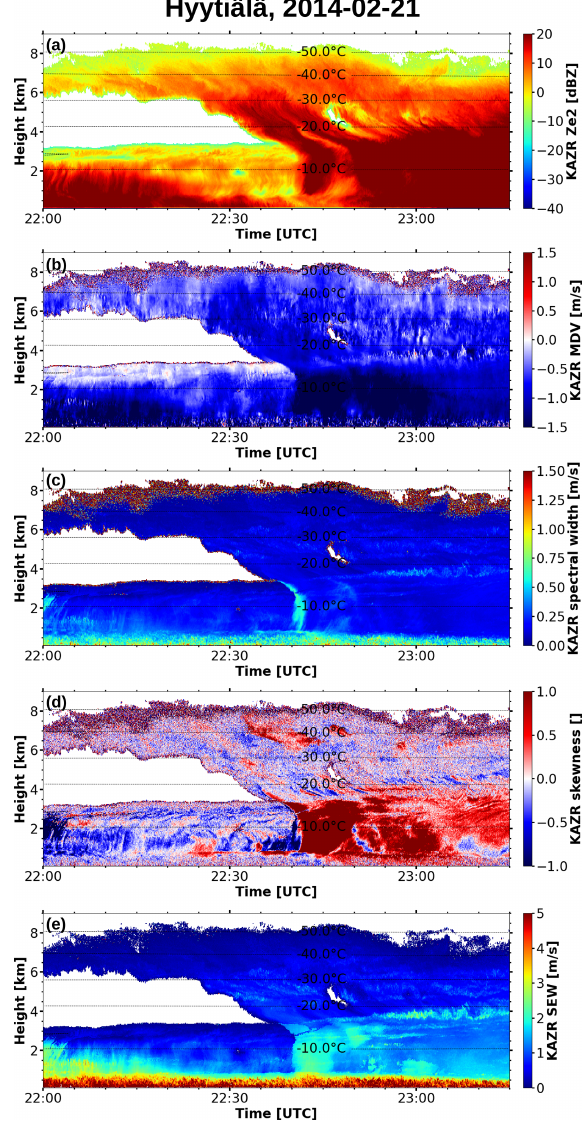
Figure 3. Radar moments measured by the KAZR in the focus pe- riod between 22:00 and 23:15UTC on 21 February 2014. (a) Equiv- alent radar reflectivity of the full spectrum in dBZ (decibels relative to Z). (b) Mean Doppler velocity (negative values indicating down- ward motion) computed from the full spectrum. (c) Spectral width computed from the full spectrum. (d) Skewness computed from the full spectrum. (e) Spectrum edge